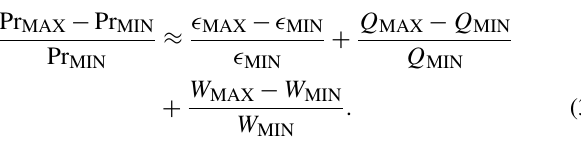
Figure 6. Relative differences between LR MAX and LR MIN sim- ulations of convective precipitation (blue, a, b ), vertical velocity (black, a, b ), surface water vapour mixing ratio (magenta, c, d ), and precipitation efficiency (green, c, d ) for median (a, c) and ex- treme (b, d) convective precipitation events as a function of the mean between the MIN and MAX daily mean temperature. The change expected according to the Clausius–Clapeyron law is dis- played in red (a, b) . Error bars represent the 95% confidence inter- val of the precipitation